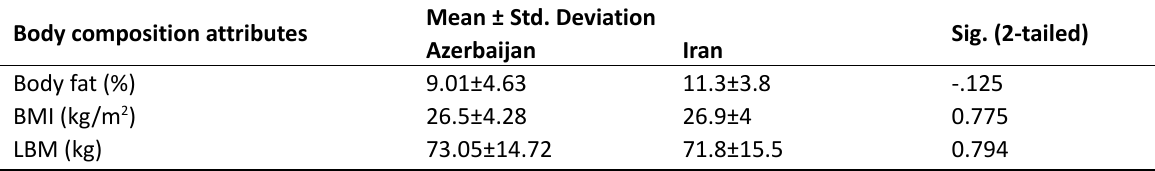
Table 1. Single-sample t-test results for comparing the body composition attributes of Azerbaijan with Iran Body composition attributes